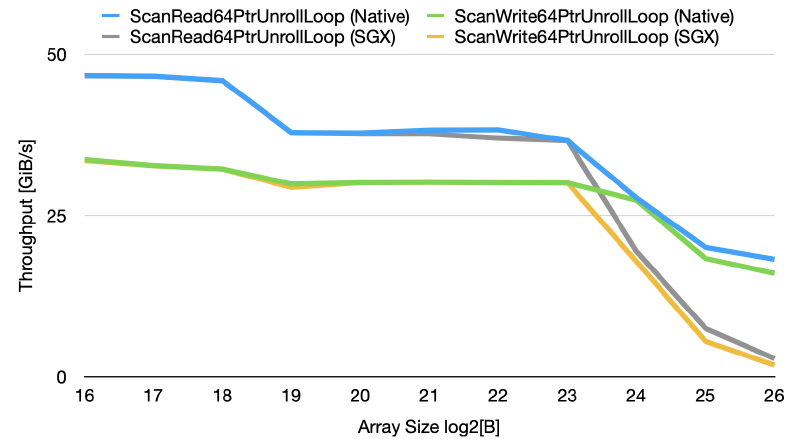
Figure 2. Caching Effects when executing read and write instructions, natively and on SGX for different array sizes.